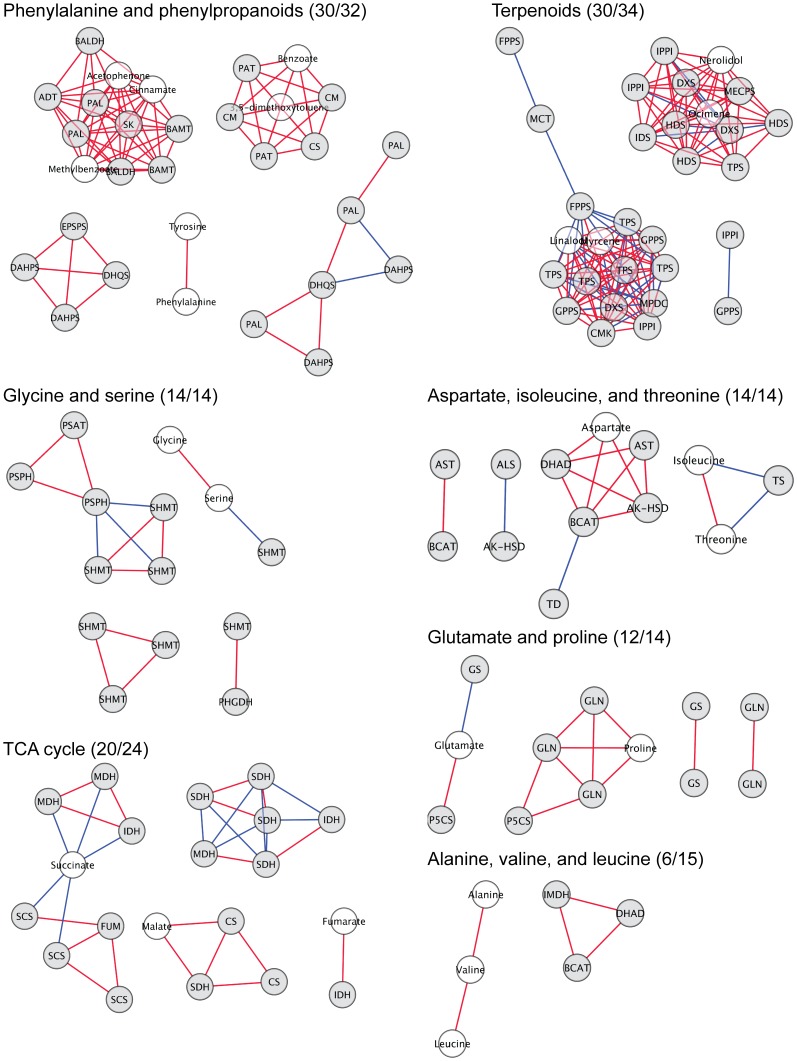
Gene to metabolite correlation network for amino acid pathways, the TCA cycle, and the phenylporpanoid and terpenoid network.Gene-to-metabolite networks in snapdragon petals. ESTs are represented by gray circles and metabolites by white circles. Red lines indicate positive correlations (r>0.95, p-value<0.05) and blue lines negative correlations (r<0.95, p-value<0.05). Numbers in parentheses describe the numbers of nodes (metabolites or ESTs) being correlated to one or more nodes and the total number of nodes in the pathway.